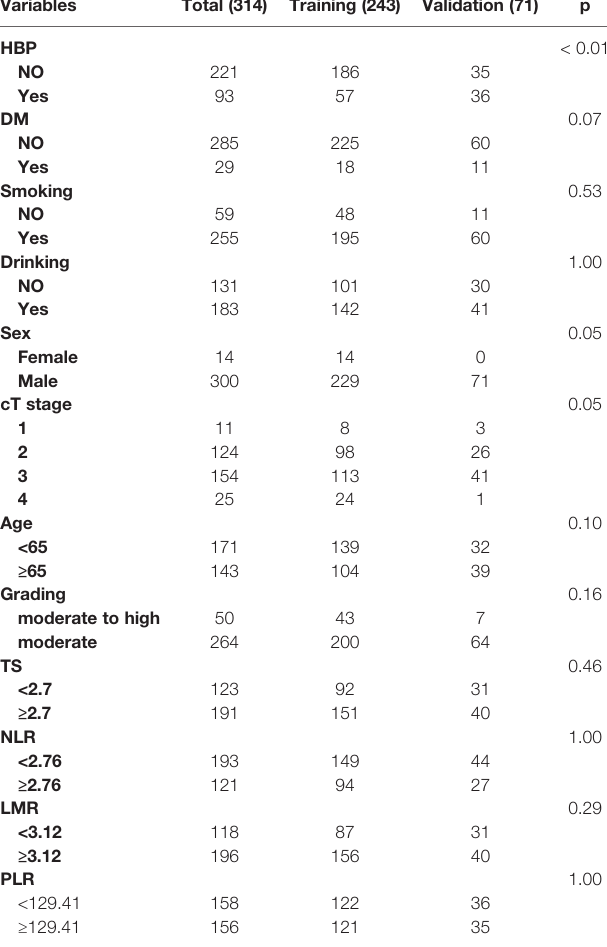
TABLE 1 | Clinicopathological characteristics of all